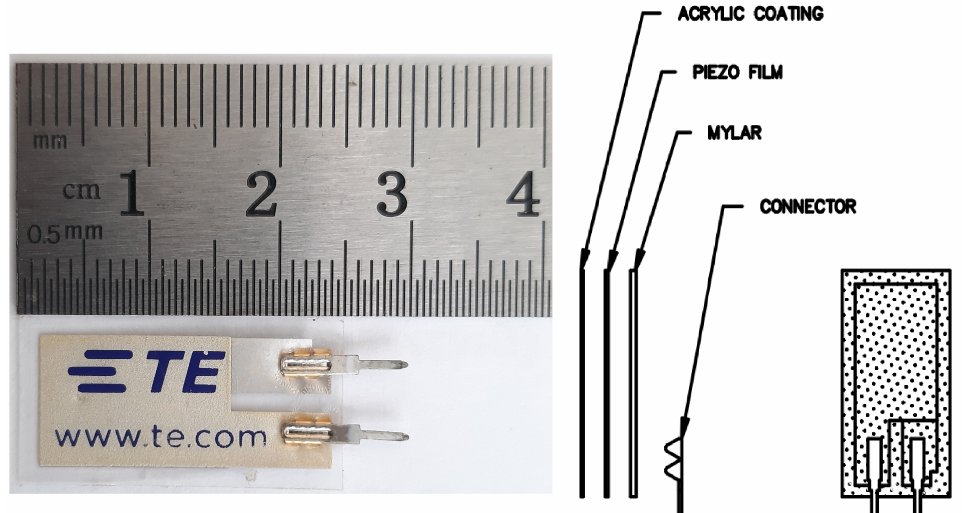
Figure 1. Sensor descriptions. Sensor illustrations ( left ), sensor dimensions ( right ).